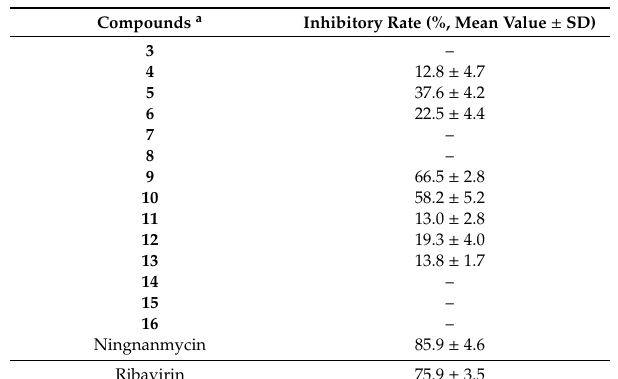
Table 1. Inhibitory activity of 3–16 against the replication of tobacco mosaic virus.